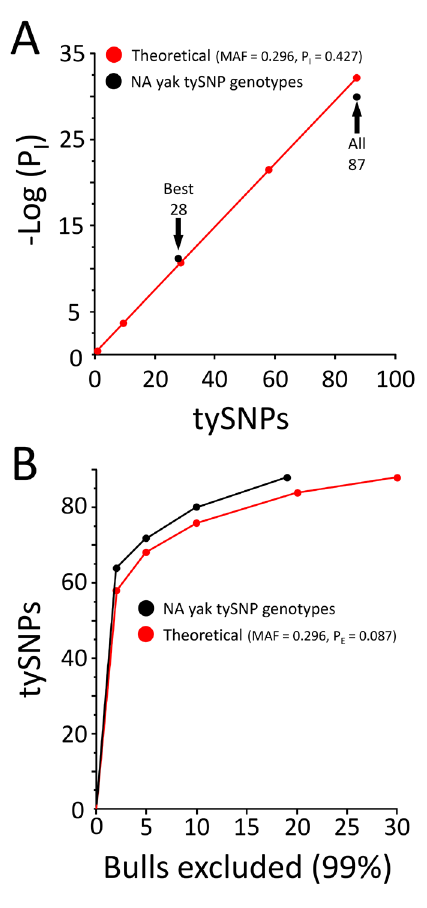
Figure 6. P and one-parent P estimates for tySNPs in NA I E yaks. ( A ) The probability of a coincidental genotype match with tySNPs. ( B ) The number of tySNPs needed to exclude 99% of the candidate bulls from parentage in the absence of the dam’s genotype information.